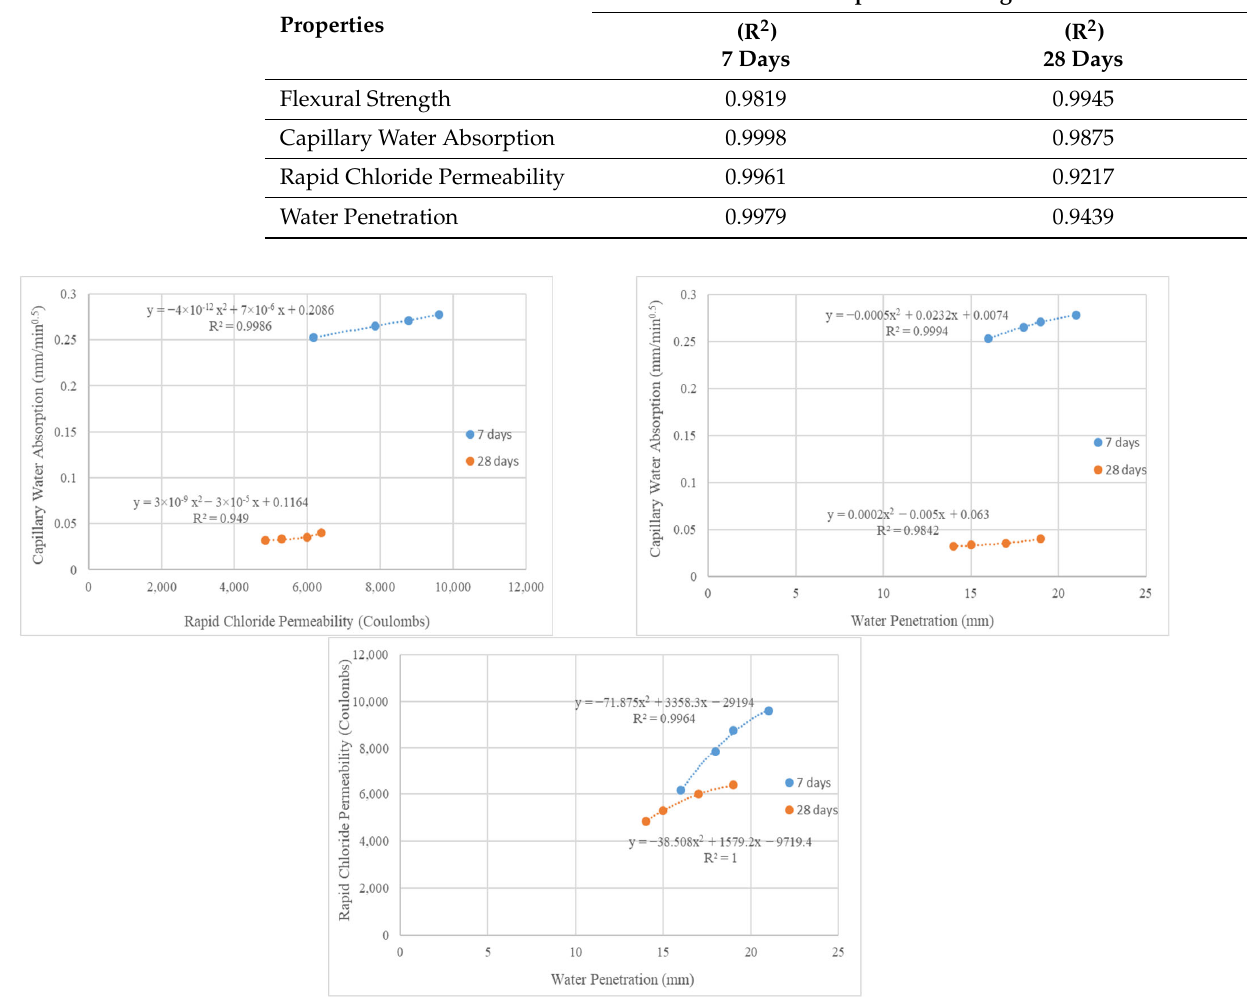
Figure 10. Correlation relations between durability properties. Table 4. Correlation coefficients between durability